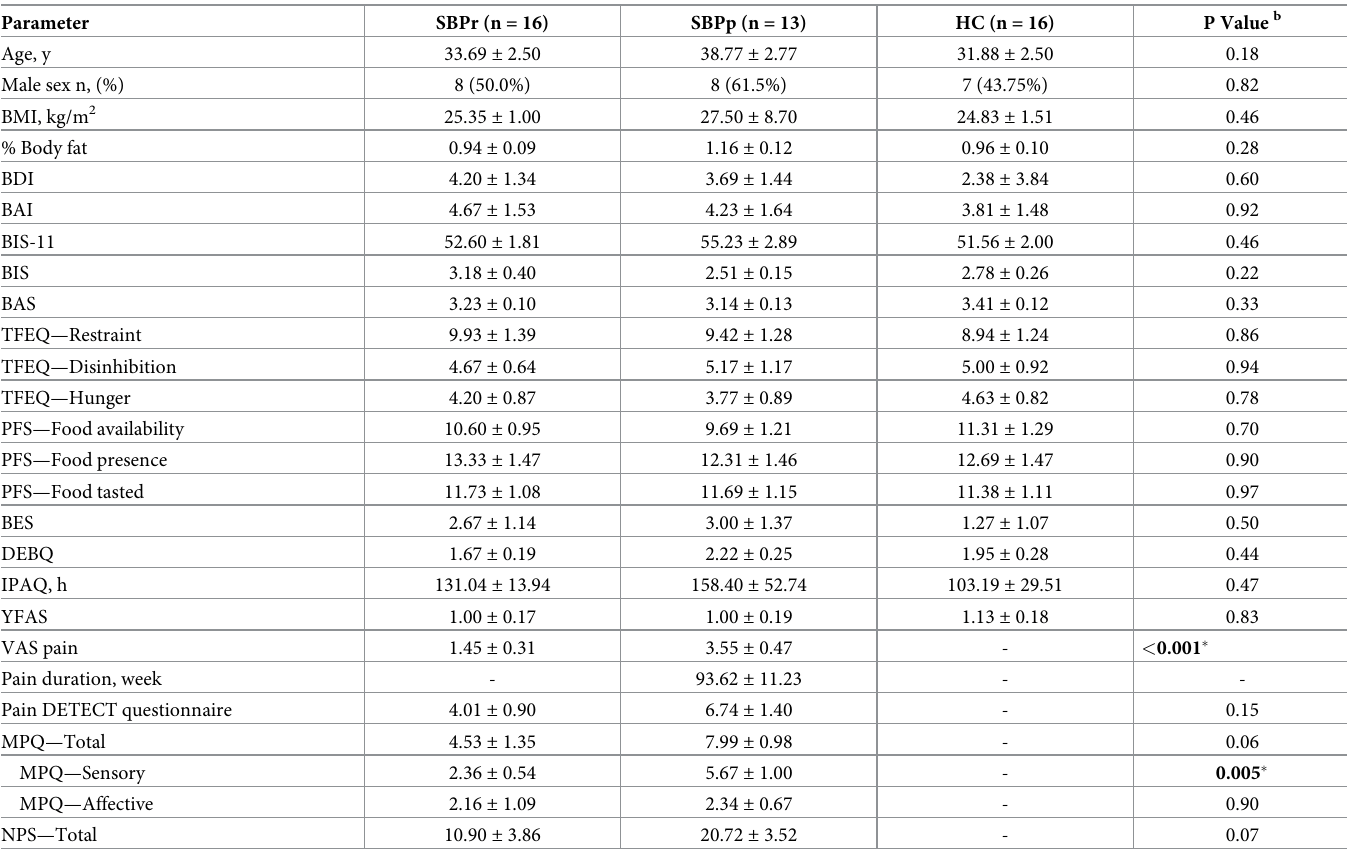
Table 3. Demographic and clinical characteristics of SBP patients at follow-up a